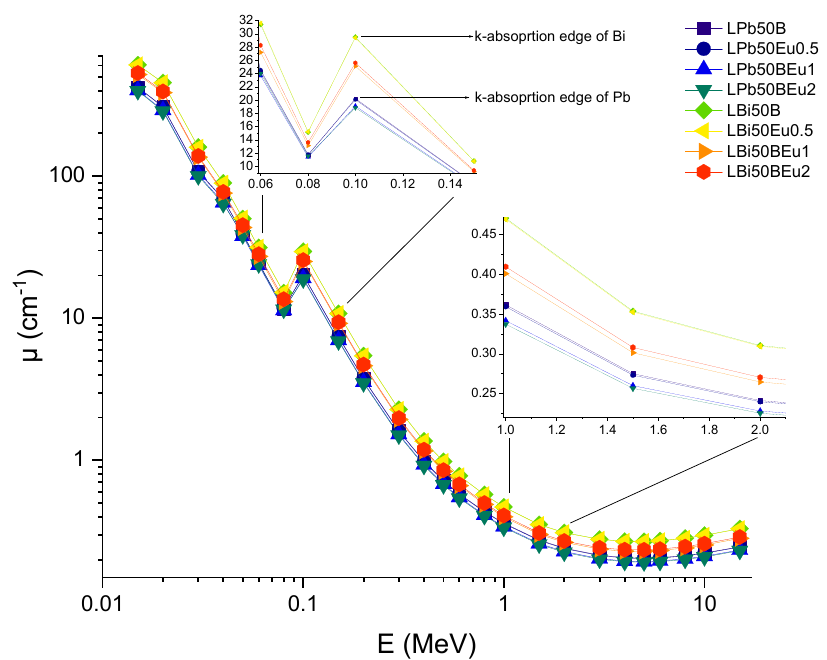
Figure 2. Variation of linear attenuation coefficients ( µ ) against photon energy for all glasses.